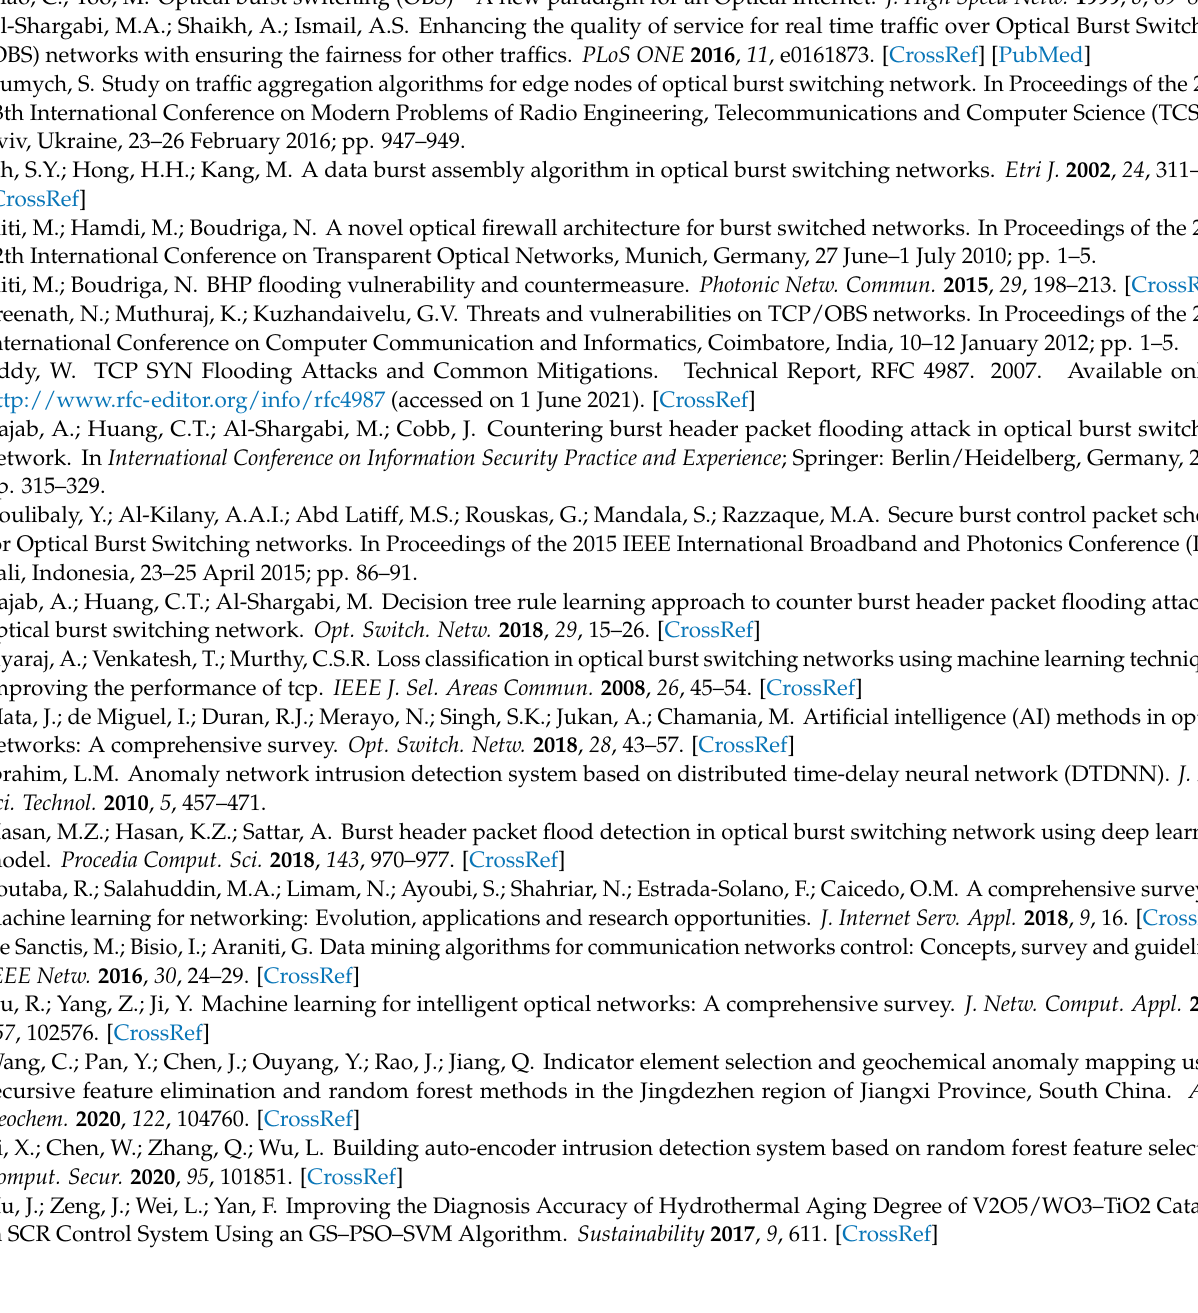
algorithm; Figure S1: Comparison of the confusion matrix (values) of the four algorithms.